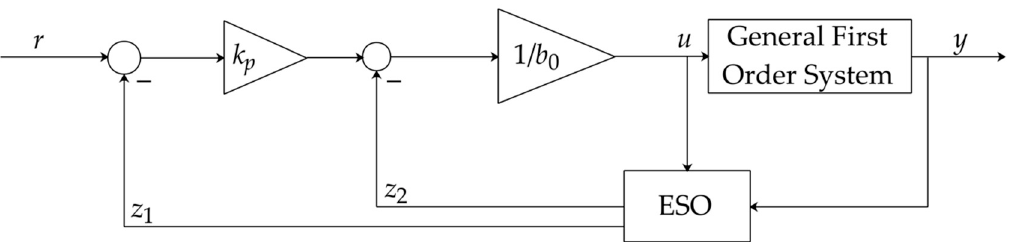
Figure 3. The block diagram of a 1st order ADRC.